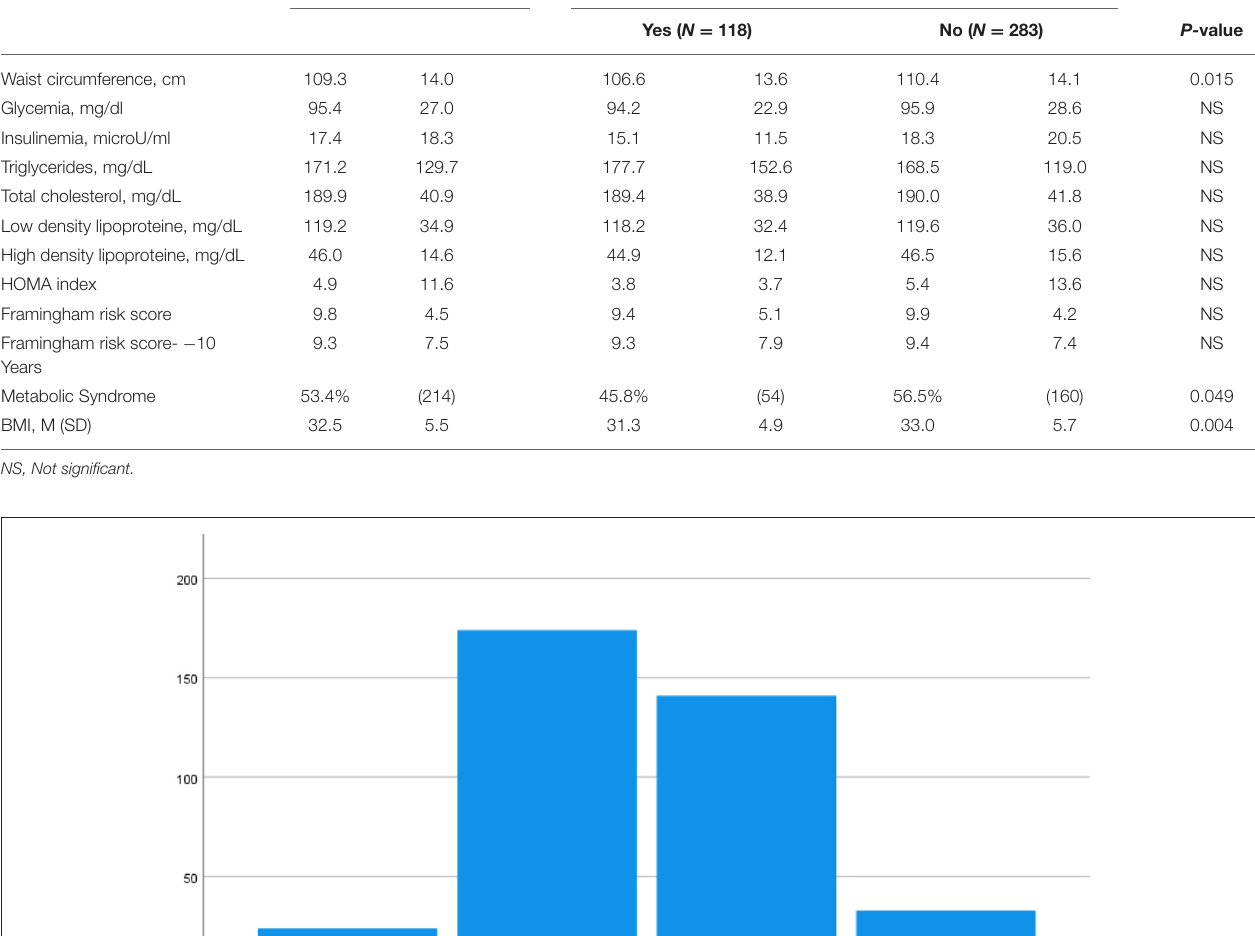
lower tendency to practice physical activity. The